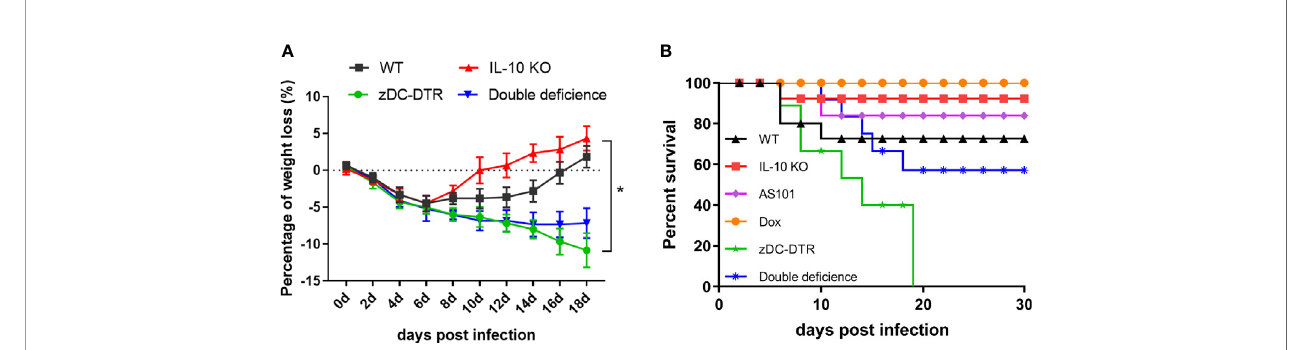
FIGURE 1 | The body weight gain and survival post Chlamydia infection. (A) Body weight gains of mice in the WT, zDC-DTR, double-de fi cient, and IL-10 − / − groups were examined every 2 days post C. psittaci infection and the body weight of all infected mice gradually declined at 6 dpi; the body weight of zDC-DTR and DD mice continued to decline up to 14 dpi; DD mice gradually attained normal body weight after day 14, whereas zDC-DTR mice did not. (B) Monitoring of the survival of mice up to 30 dpi. More than 90% of IL-10 − / − mice, 85% of AS101-treated mice, 70% of WT mice, and 60% of DD mice were alive after 30 days. All zDC-DTR mice died, whereas all mice in the Dox group survived during the observation period. Differences were analyzed by ANOVA (* P